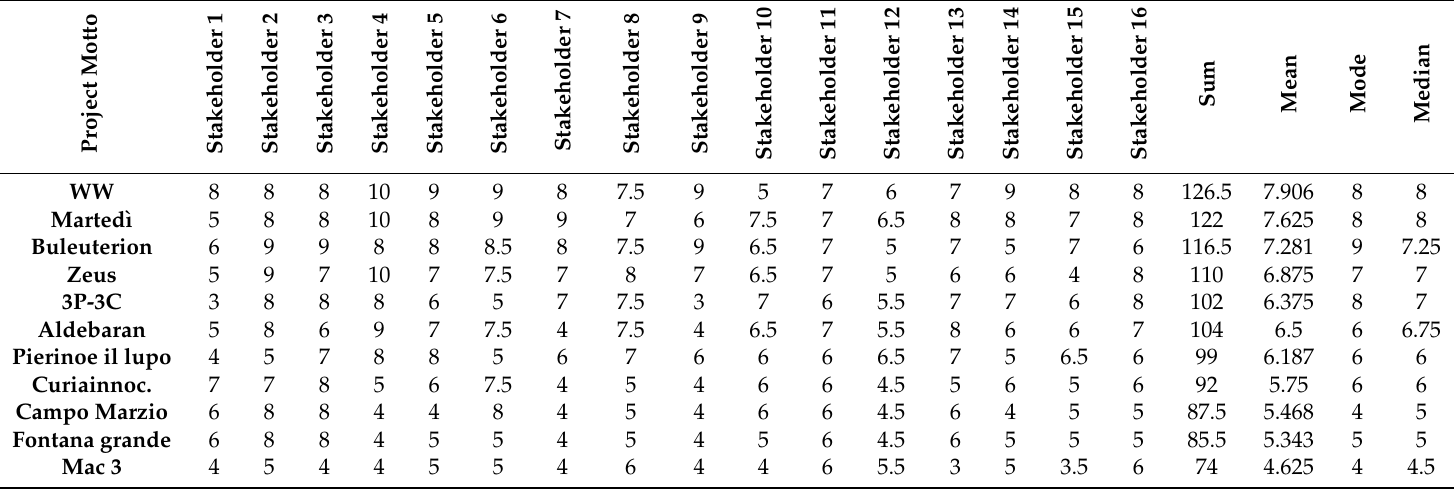
Table 8. Example of the qualitative criterion “architectural quality”—heuristic method to pre-order the